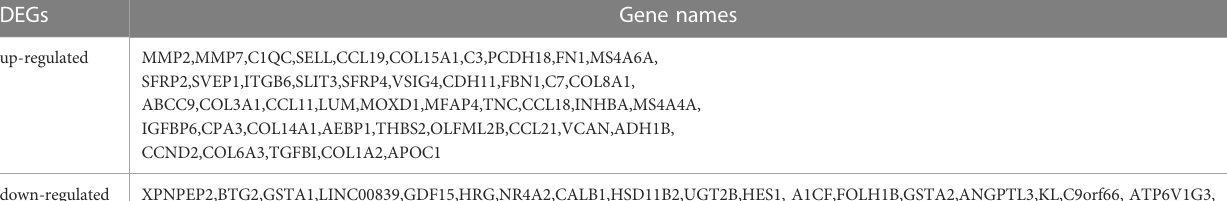
TABLE 1 Differential expression genes identi fi ed from two data sets. DEGs